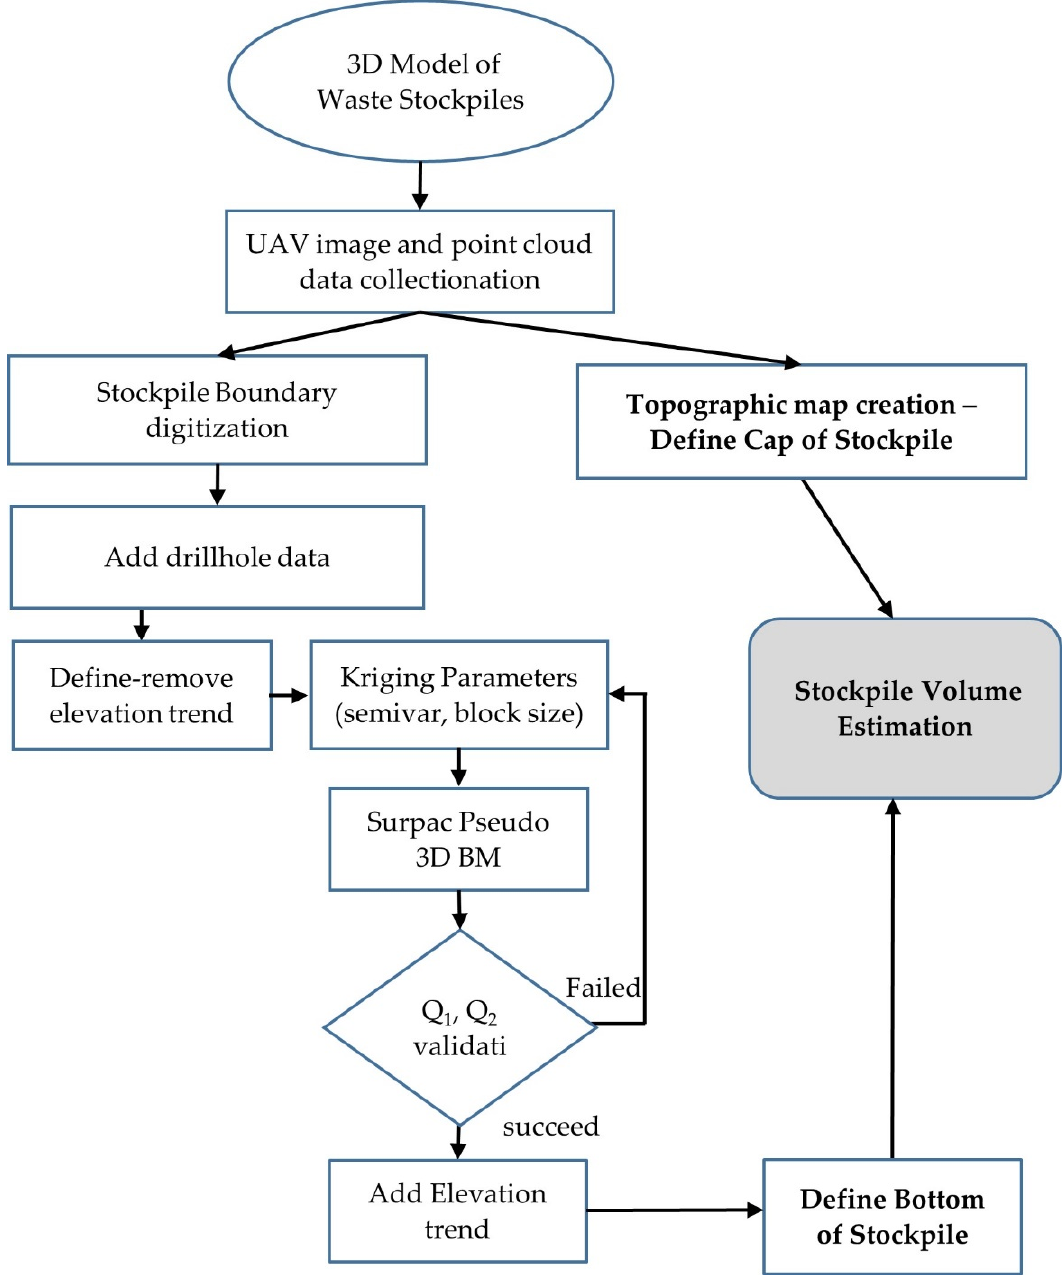
Figure 4. Schematic diagram of the proposed methodology.